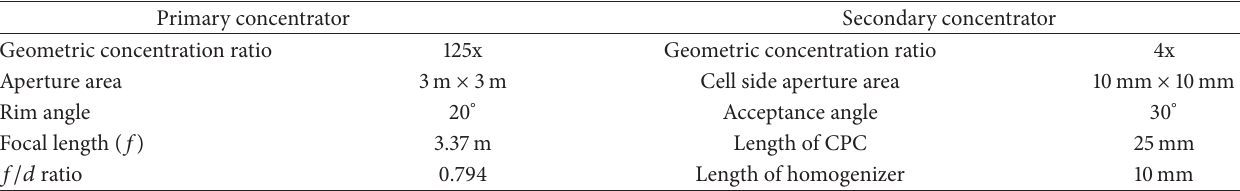
Figure 1: Schematic of the system configuration and particular of the receiver. Table 1: Concentrator specifications.